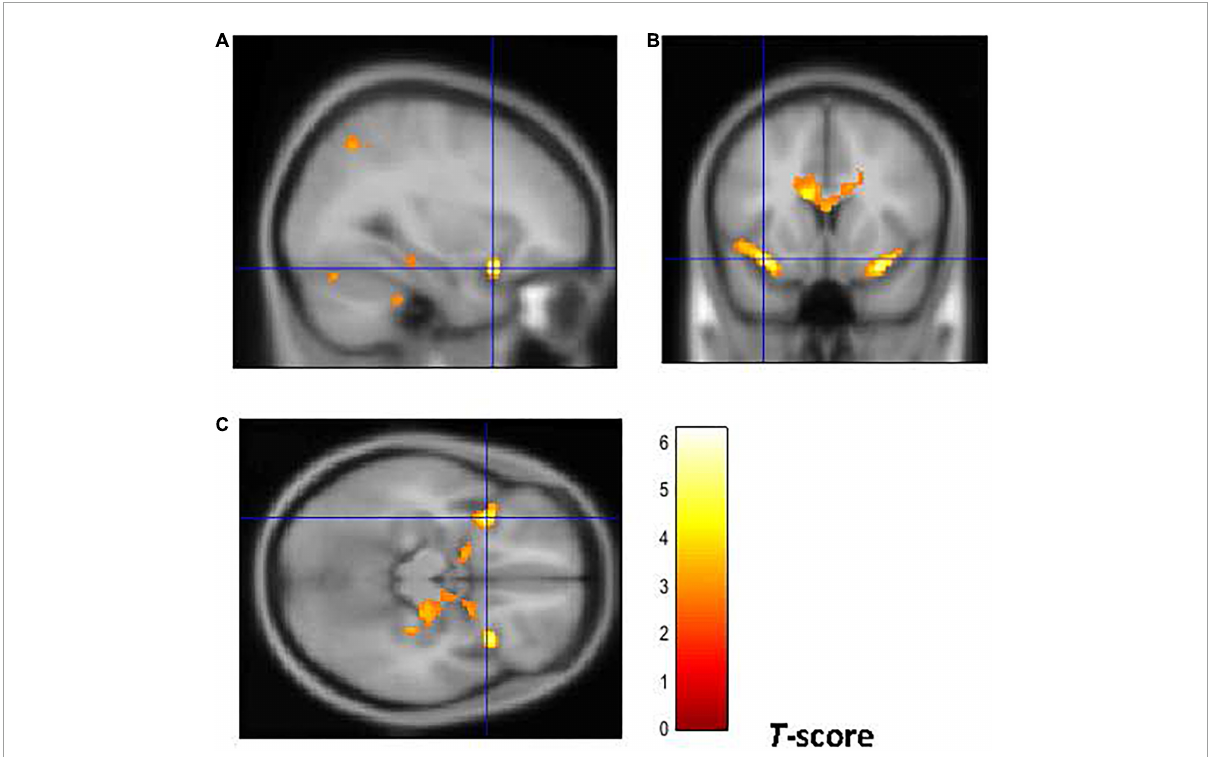
FIGURE4 Brain regions of interest displaying lower GM volume in early onset smokers in comparison to late onset smokers. The figure shows early onset smokers to display lower GM volume in the bilateral AI [region of interest centered at 32, 15, –18 MNI coordinates in sagittal plane (A) , and at –34, 14, –15 in coronal (B) and axial (C) planes] in comparison to late onset smokers. The cluster forming threshold consisted in p < 0.01 with a minimum of 100 contiguous voxels per cluster at a whole-brain corrected level. TIV, age, and biological sex were inserted as covariates of no